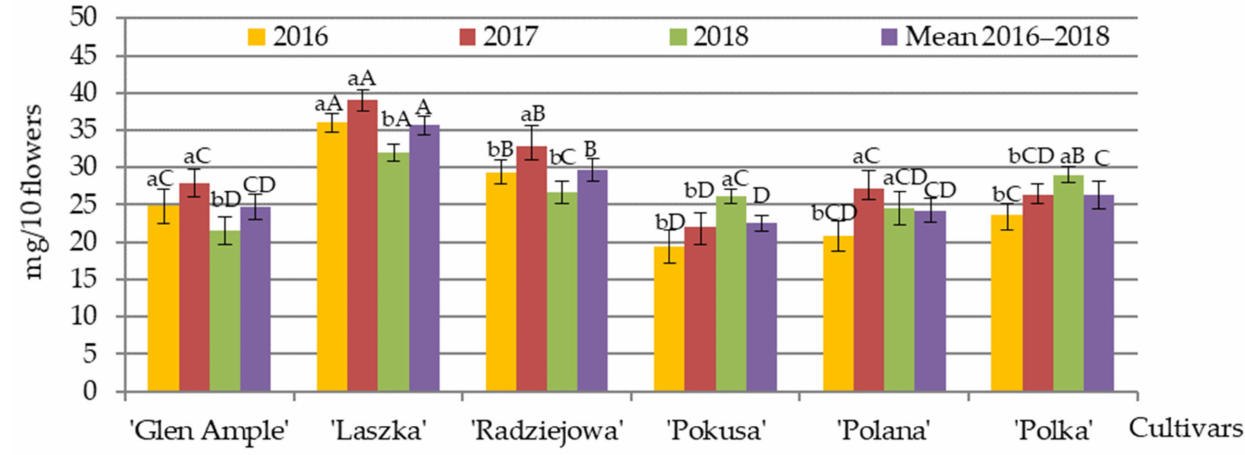
Figure 8. Mass of pollen produced by 10 flowers of R. idaeus cultivars. Explanations: means followed by the same small letter are not significantly different within the cultivars for the years and means followed by the same capital letter do not differ between the cultivars in each year at a significance level α = 0.05; (number of repetitions in each year n = 10). Bars indicate standard deviation.